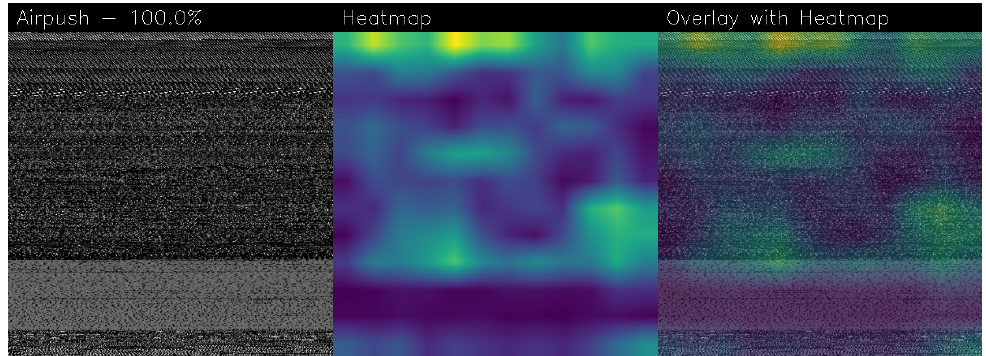
Figure 8. Sample classified as belonging to the Airpush family (4a985c341e1ee08f647395d00640c1f2) with 100%, where we can note that the yel- low areas are on the upper side of the image, obtained with the model built using the Standard-CNN